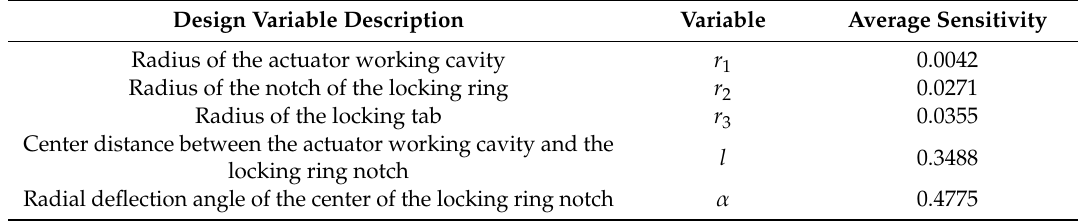
Table 5. The absolute values of the average variable sensitivities of [ L ] in the design space.